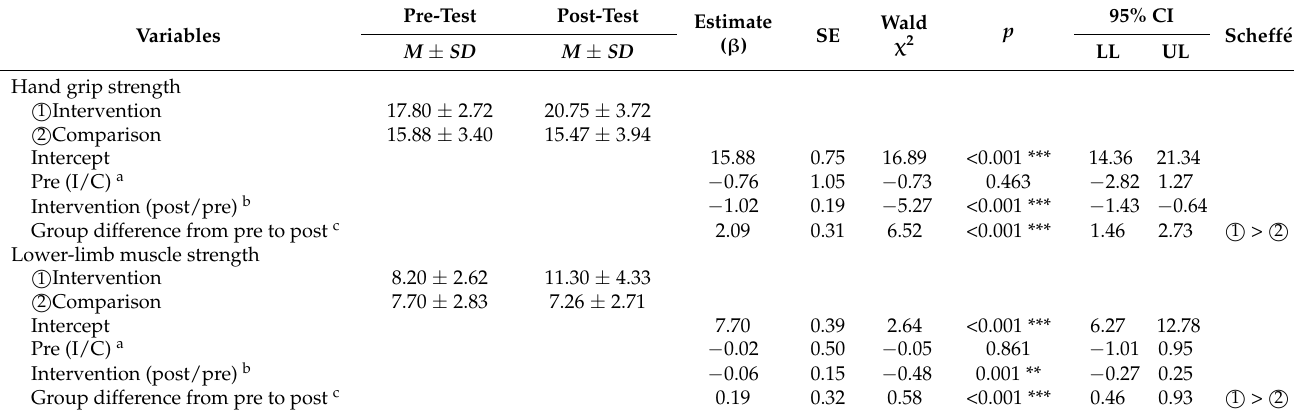
Table 3. Group comparisons in changes in functional fitness and daily life